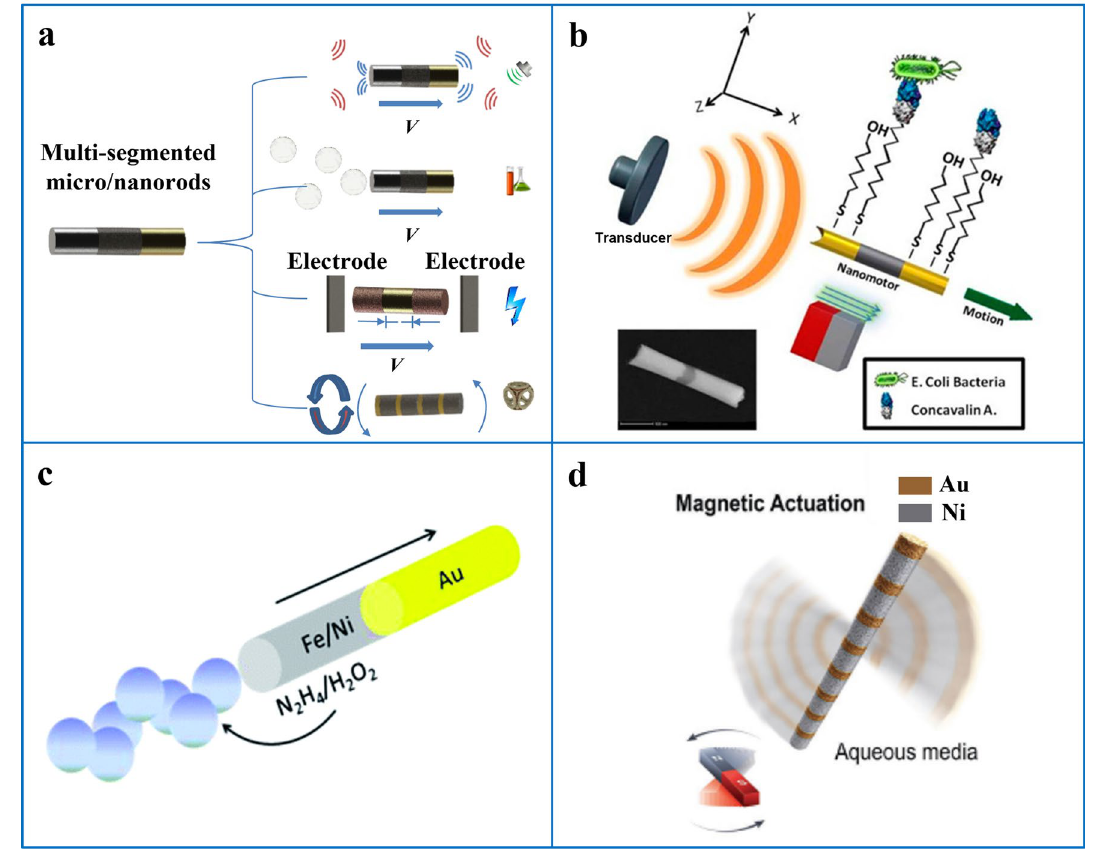
Fig. 5 a Multi-segment nanorods driven in ultrasonic fields, chemical fuels, electric field and magnetic fields. b Motion of Au/Ni/Au nanomo- tors in the ultrasonic field. Reprinted with permission from Ref. [159]. Copyright (2013) American Chemical Society. c Schematic illustration of the driving of the Au/Fe/Ni alloy nanomotor in a mixed fuel composed of hydrogen peroxide and hydrazine. Reproduced with permission from Ref. [127]. Copyright (2011) Royal Society of Chemical. d Schematic diagram of the magnetic response of the (Au/Ni) 8 nanomotor. Repro- duced with permission from Ref. [21]. Copyright (2017) John Wiley &